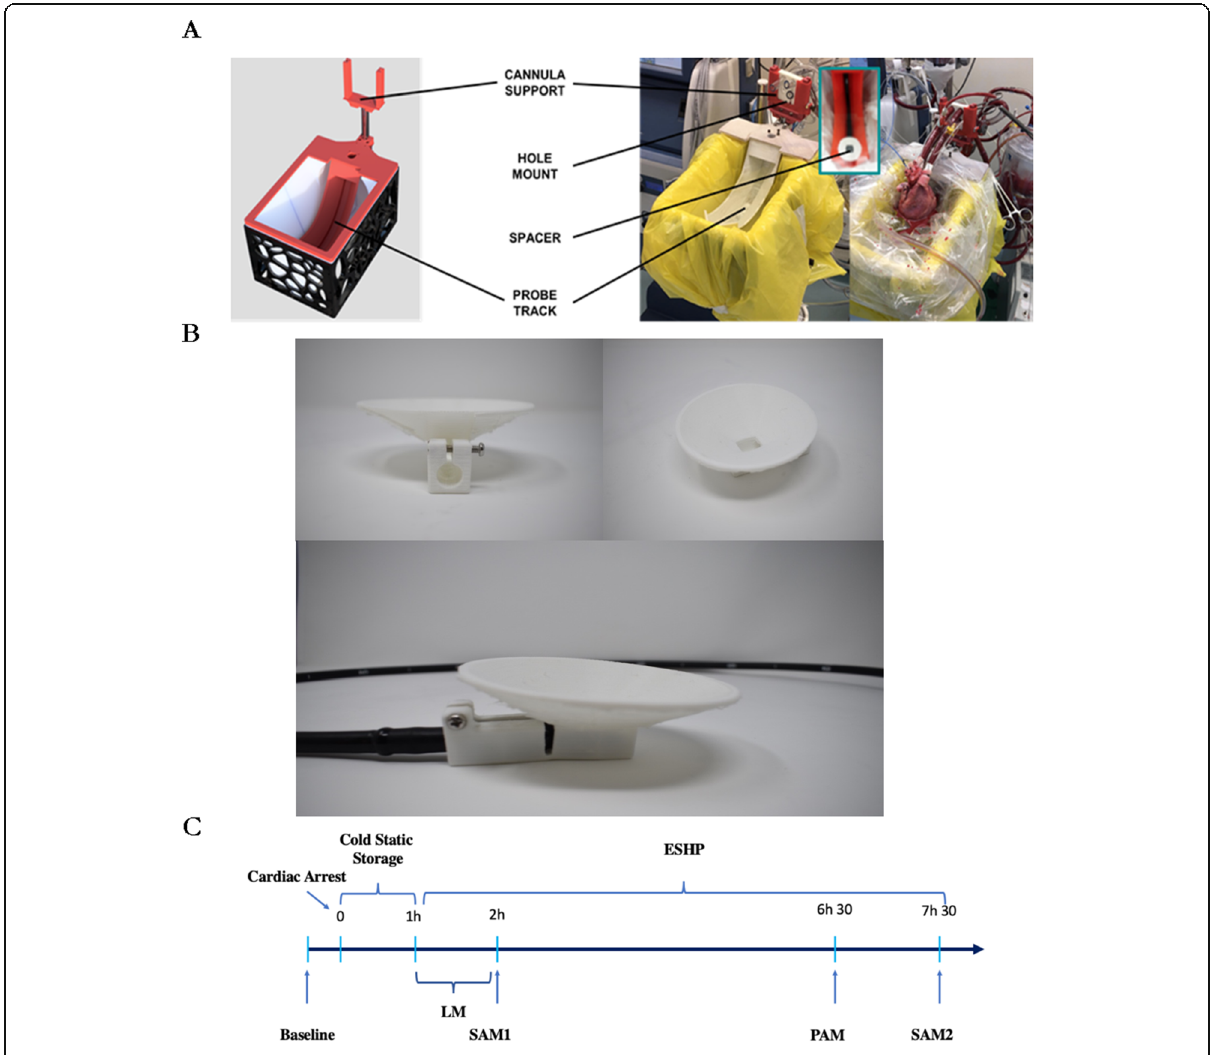
Fig. 1 Experimental design showing A setup, B custom made 3D-printed spacer, and C experimental